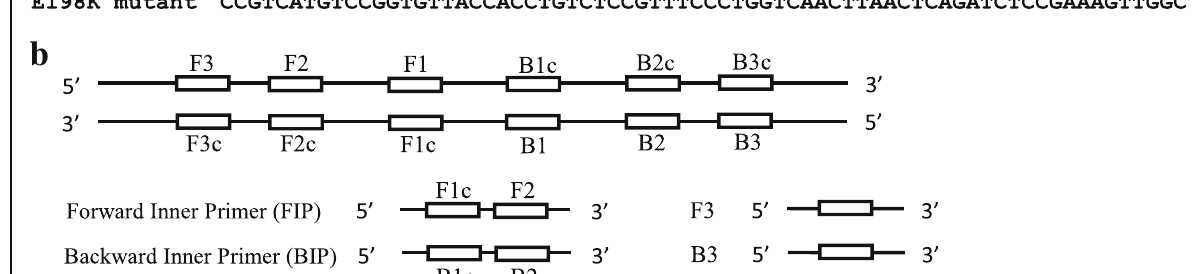
Fig. 1 Design of LAMP primers for detection of the E198K/A/V mutations of TUB2 in Botrytis cinerea . a Nucleotide sequence alignment of sensitive and resistant genotypes. The sequences used as LAMP primers are indicated by bars. Point mutations are shown underlined with one line and mismatches are shown underlined with double lines. For each mutation, the F2 primer ends with its corresponding mutated nucleotide. b Schematic representation of the LAMP primers used in this work. The inner primer FIP consists of F1c and F2, and BIP comprised of B1c and B2. Primers ending with ‘ c ’ are complementary to their counterparts without ‘ c ’